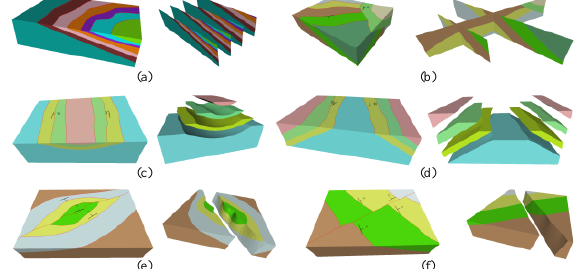
Figure 3. Simulation of typical geological structures; (a) conformable stratum model; (b) unconformable stratum model; (c) syncline model; (d) anticline model; (e) normal fault model; (f) parallel fault model.